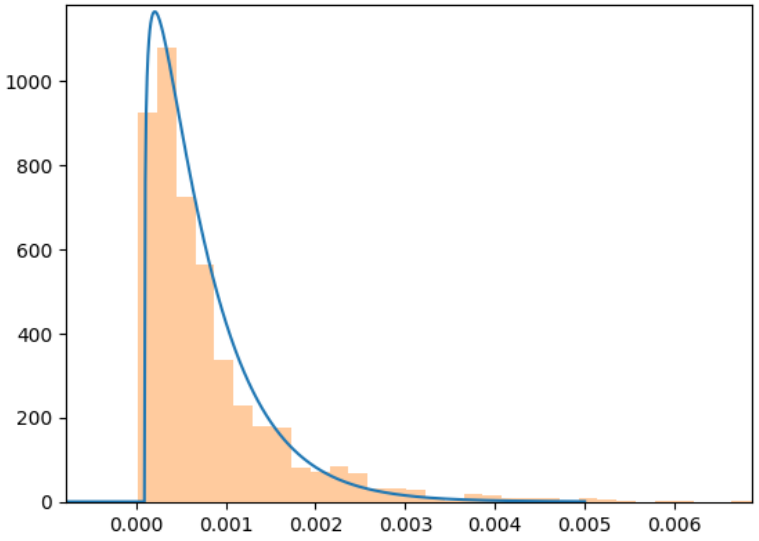
Figure 5. Distribution of reconstruction error over the training